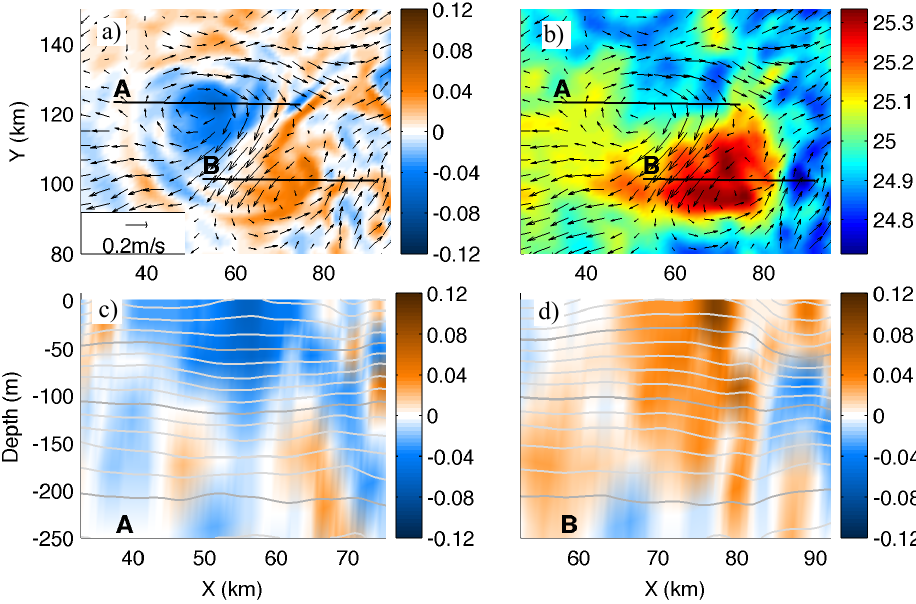
line) which balances the rate of change in the volume except for a relatively small net advection. Fig. 9. Final eddy pair observed southwest of the cape from day 31 (Fig. 4). (a) PV and velocity vectors at the surface. (b) Potential density